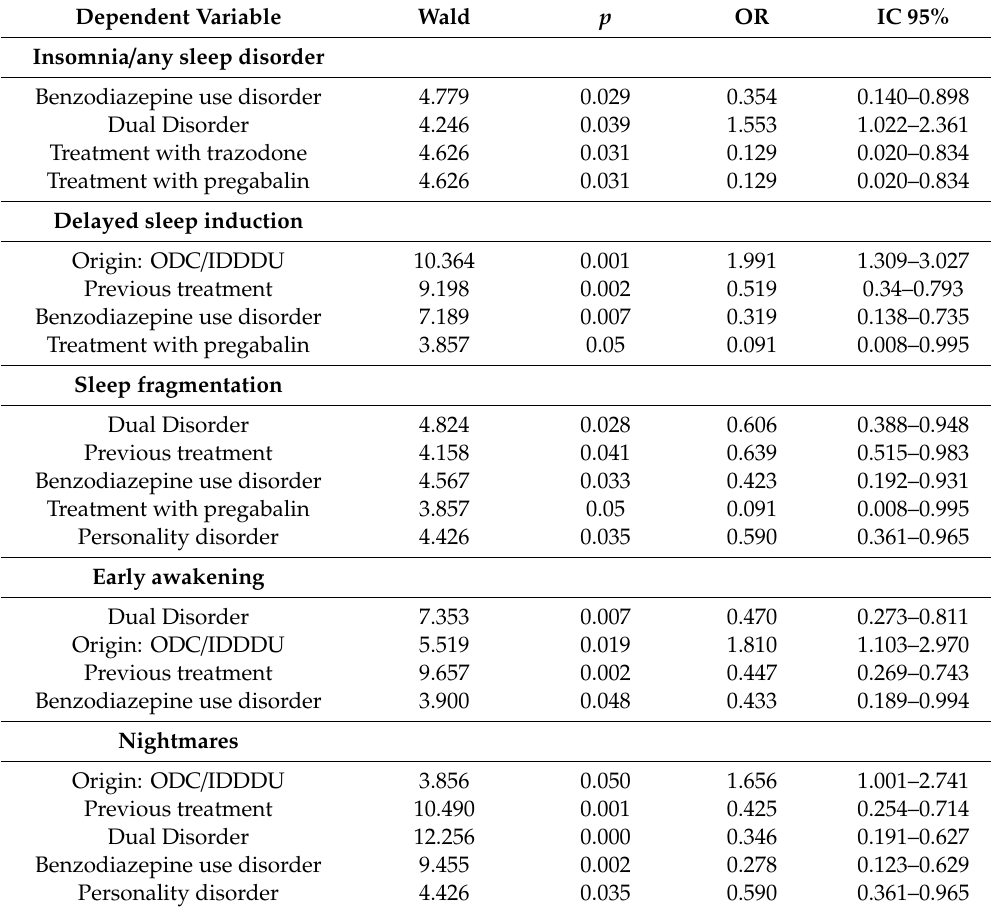
Table 4. Several binomial logistic regression analyses with the dependent variable varying among sleep disorder subgroups. Abbreviations; IDDDU: Inpatient Dual Diagnoses Detoxification Unit; ODC: Outpatient Drug